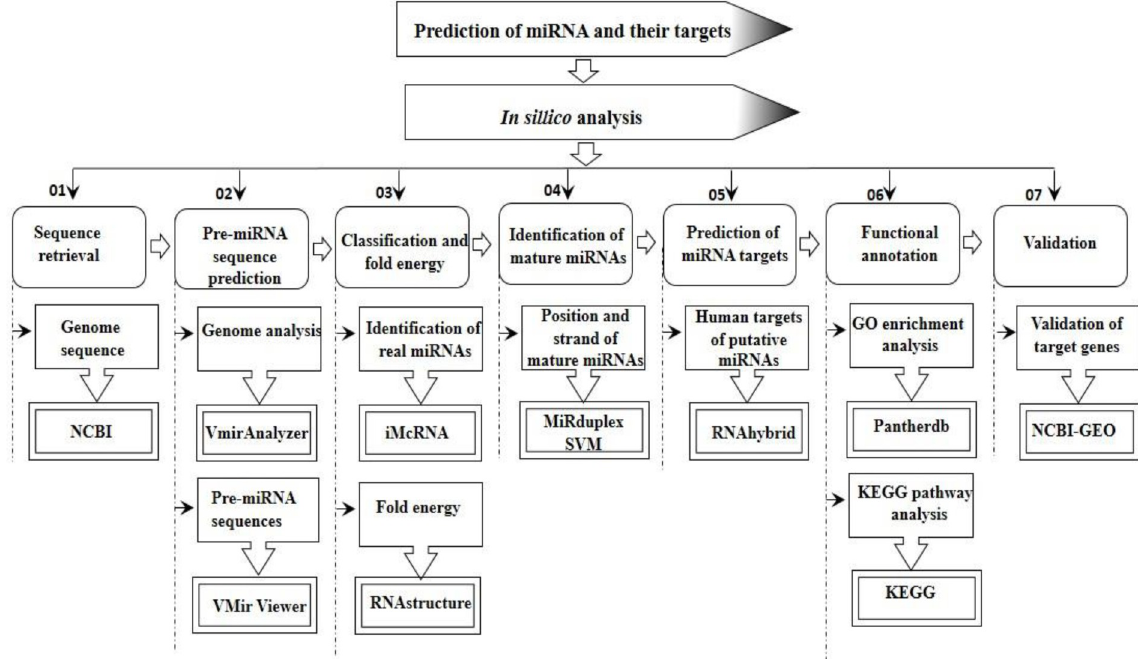
Fig 1. Graphical synopsis of representing the overall strategy used in the prediction of miRNA and their cellular targets.